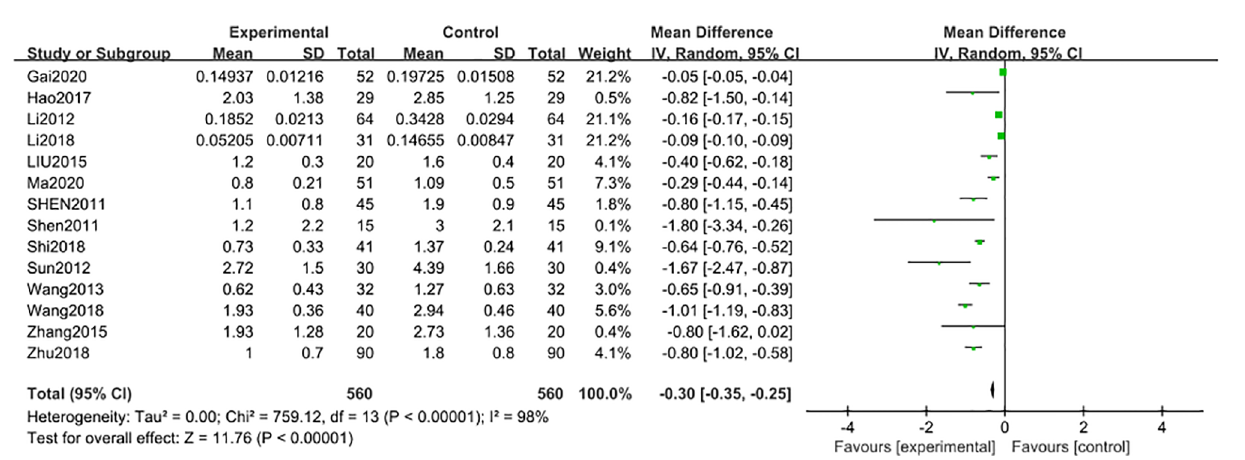
FIGURE 2 | 24 h-UTP after 3 months: comparison of treatment combined with TG against basic treatment.